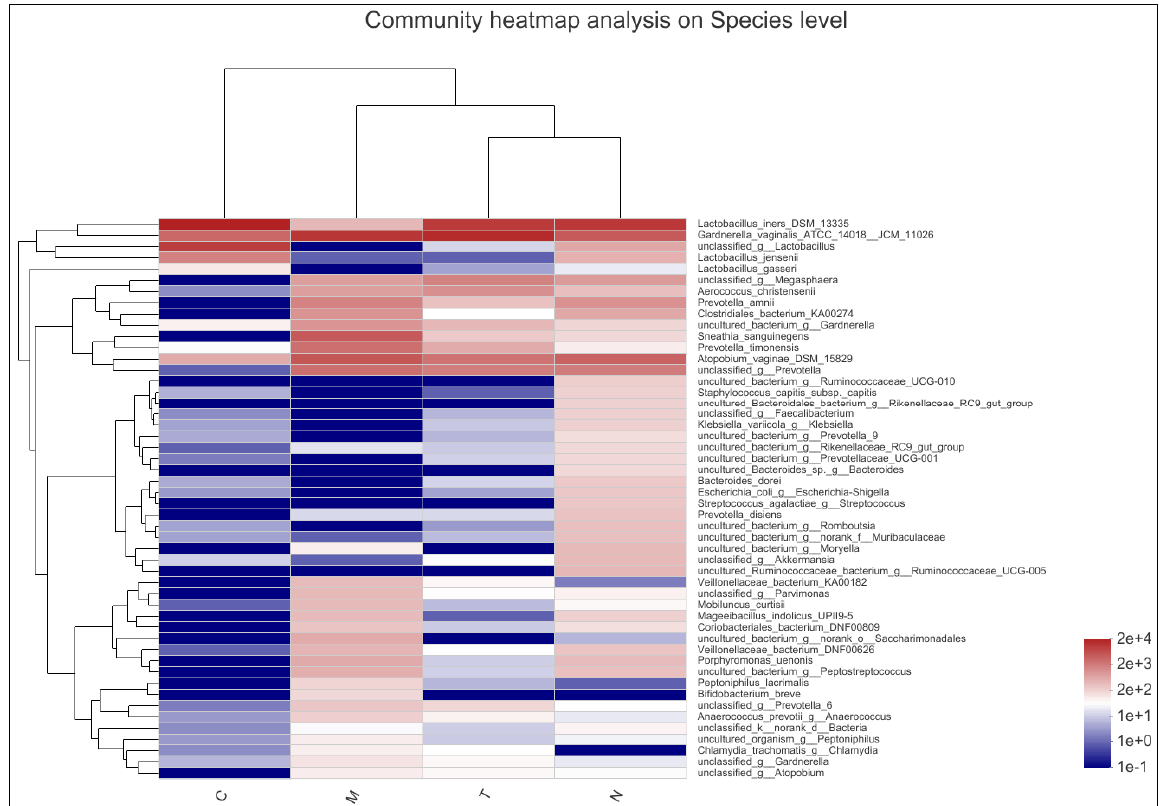
Figure 2. Results of community heatmap analysis at species level, with the group names and species names plotted on the x -axis and y -axis, respectively. Color gradients indicate the changes in the abundance of various samples across the different groups, and the values represented by the color gradients are shown on the right side of the heatmap. 2e+4 = 2 × 10 4 ; 2e+3=2 × 10 3 ; 2e+2 = 2 × 10 2 ;